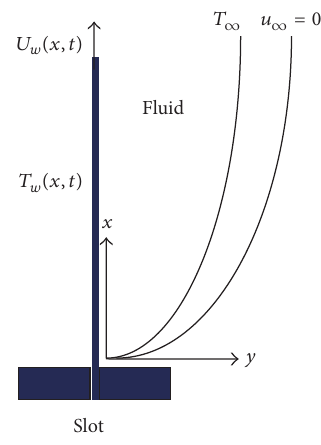
Figure 1: Physical model and coordinate